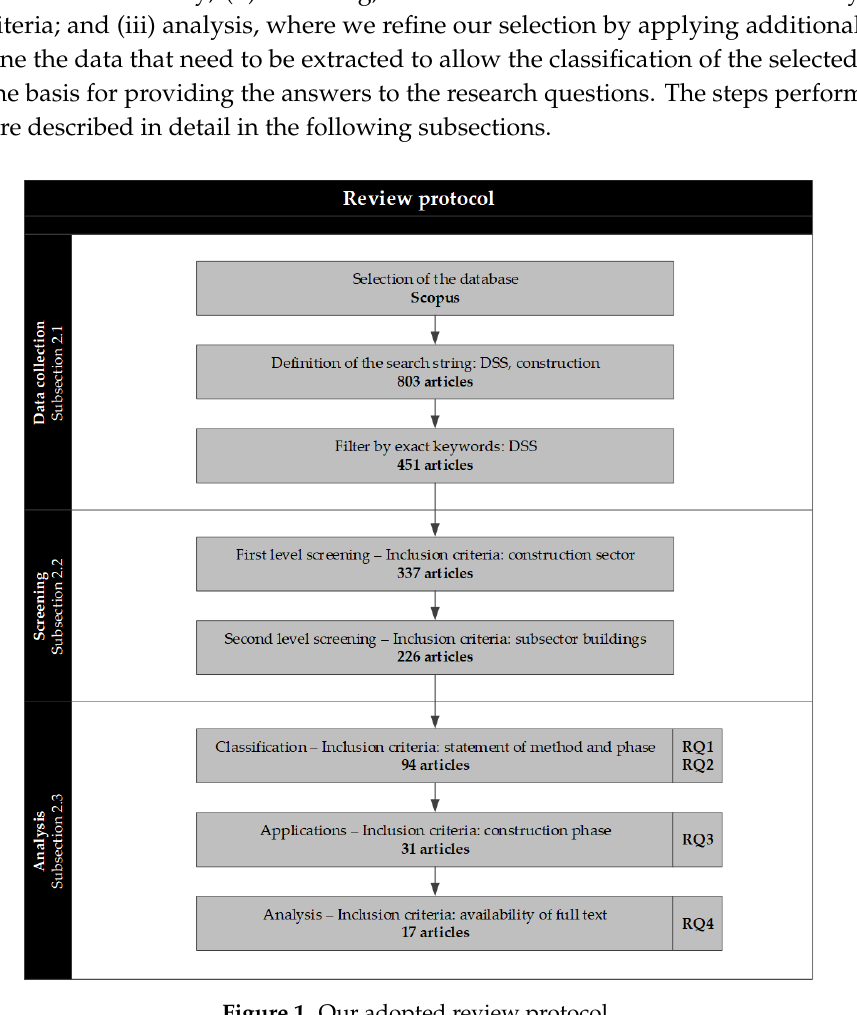
Figure 1. Our adopted review protocol. Table 1. Search items and search string.